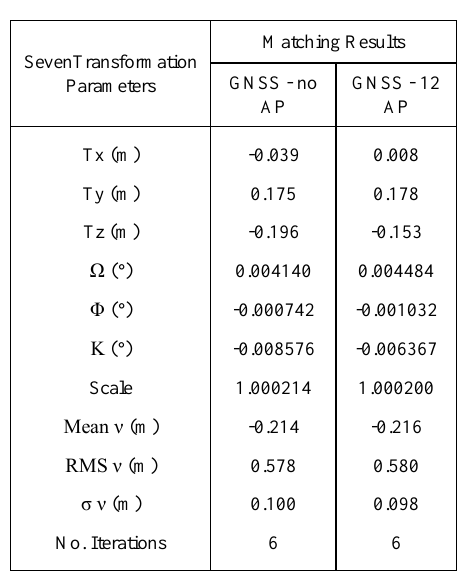
Figure 5: Easting RMS at 50 independent check points.